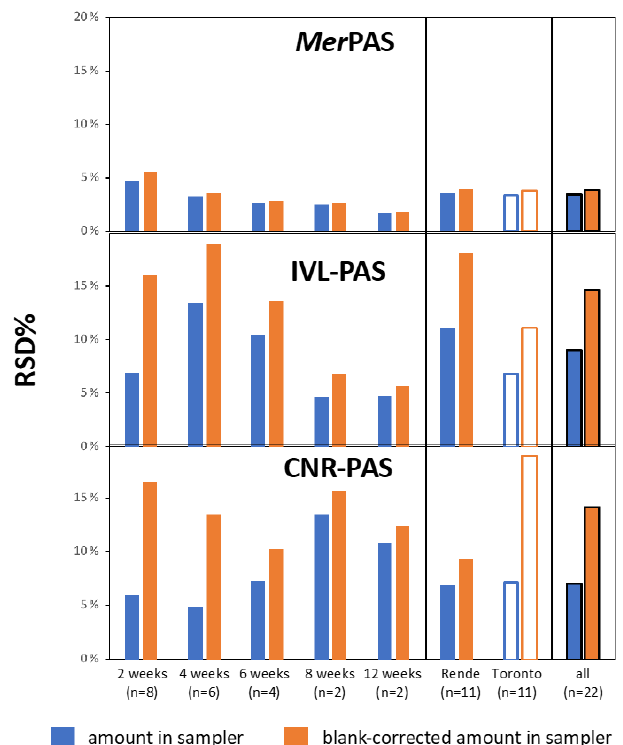
Figure 2. Precision expressed as the relative standard deviation in percent of the amounts of mercury quantified in triplicate PASs, both before (blue) and after blank correction (orange), averaged over different deployment lengths, across different locations, and over all replicated deployments. Note that in some cases a sampler was lost and therefore some deployments were only